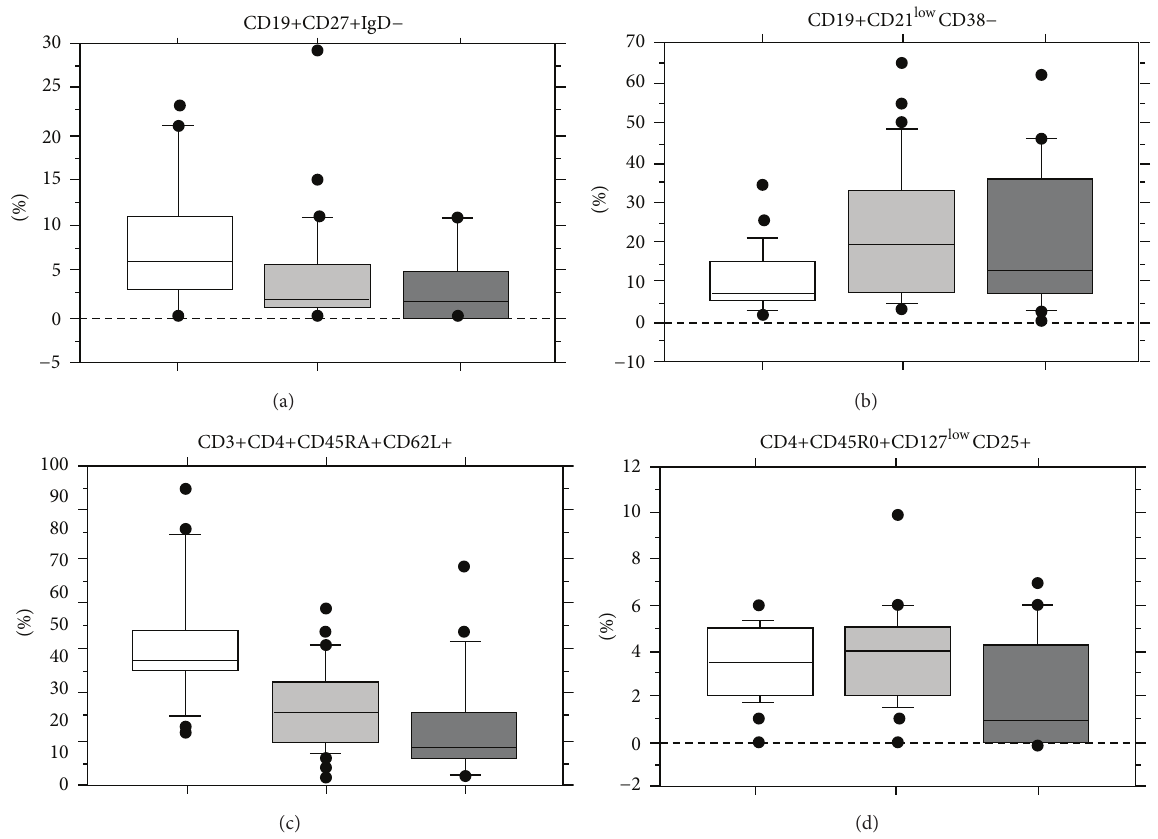
Figure 4: Peripheral blood lymphocyte immunophenotype in PAD patients without spleno-portal axis abnormalities (white square), with isolated splenomegaly (gray square) and abnormalities of spleno-portal axis (black square). CD19+27+IgD − (switched memory B cells), CD19+CD21 low B cells, CD3+CD4+CD45RA+ (na¨ıve CD4+ T cells), and CD4+,CD25+CD127 − (regulatory T cells) are shown. Results are expressed as percentages ±